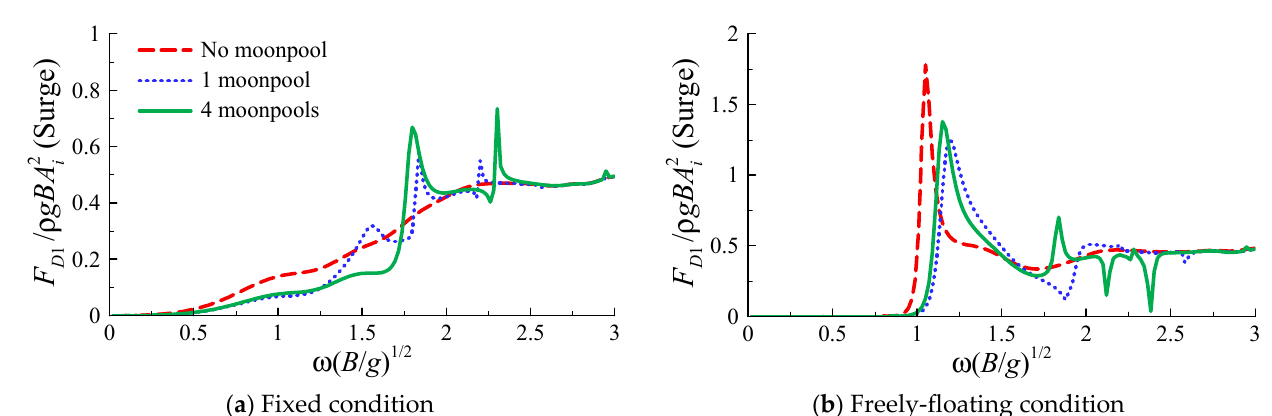
Figure 12. Calculated mean surge drift forces on a barge with/without moonpool(s) in head waves (wave angle β = 0°).